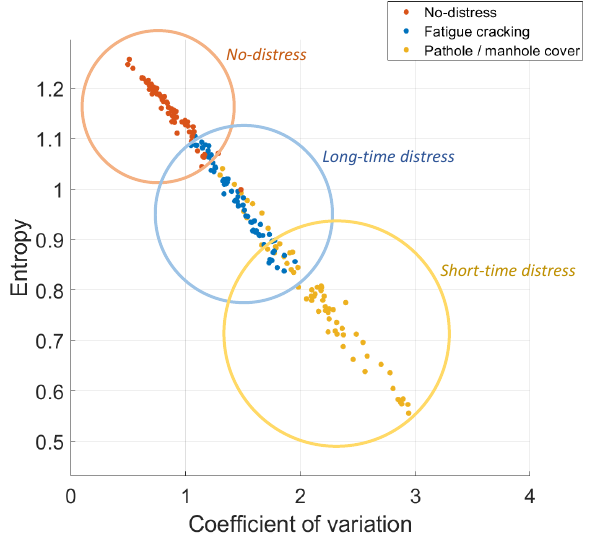
Figure 7. Distribution in the feature space of the data collected on both the car’s dashboard and the car’s